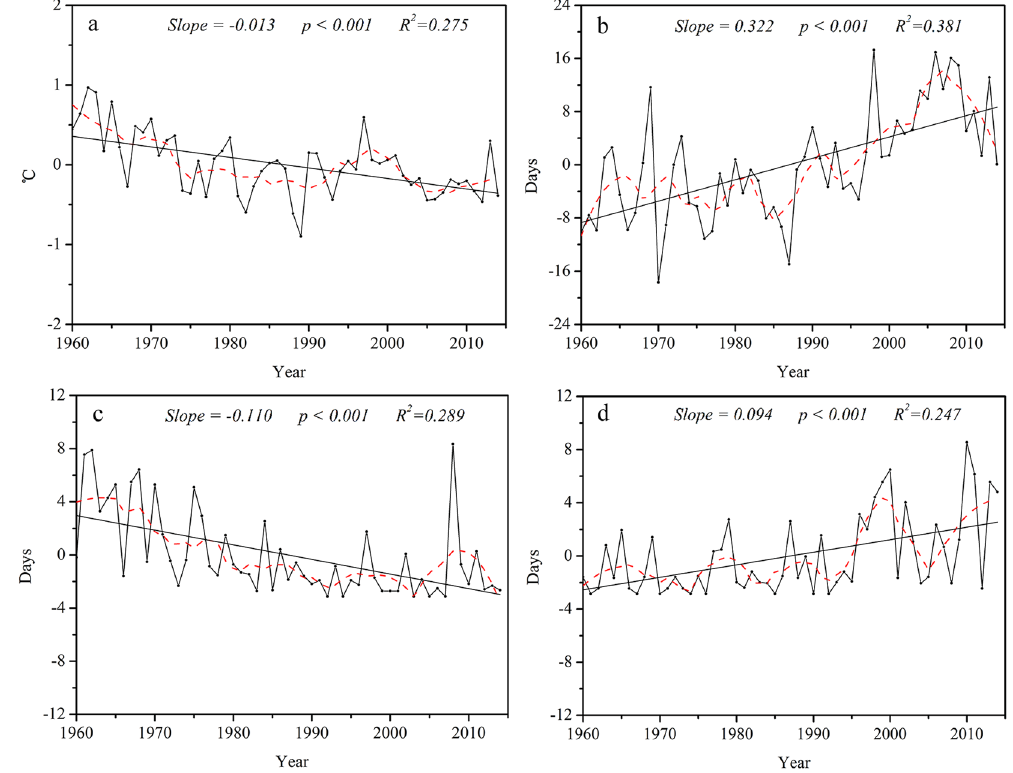
Figure 7. Annual regional averaged series for diurnal temperature range and the duration indices. Diurnal temperature range ( a ), growing season length ( b ), cold spell duration ( c ), warm spell duration ( d ). For description of indices, see Supplementary Table S1. Straight line represents linear regression and the dash line is the 10-year smoothed average.